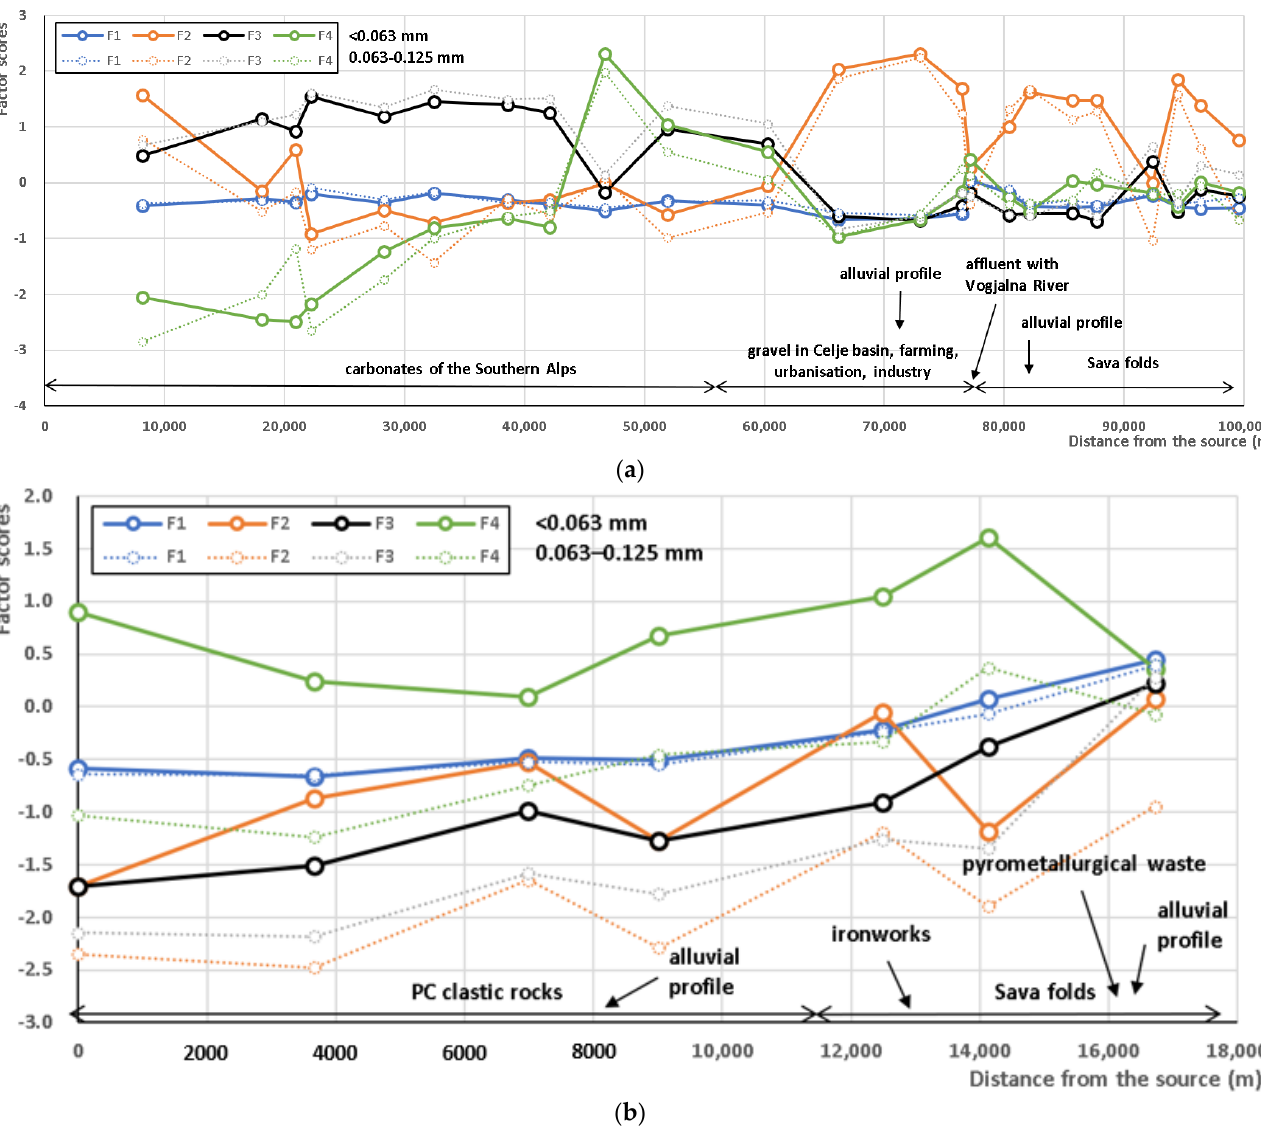
Figure 5. Factor scores distribution in stream sediments of the Savinja ( a ) and Voglajna ( b ) rivers for fractions <0.063 and 0.063–0.125 mm.